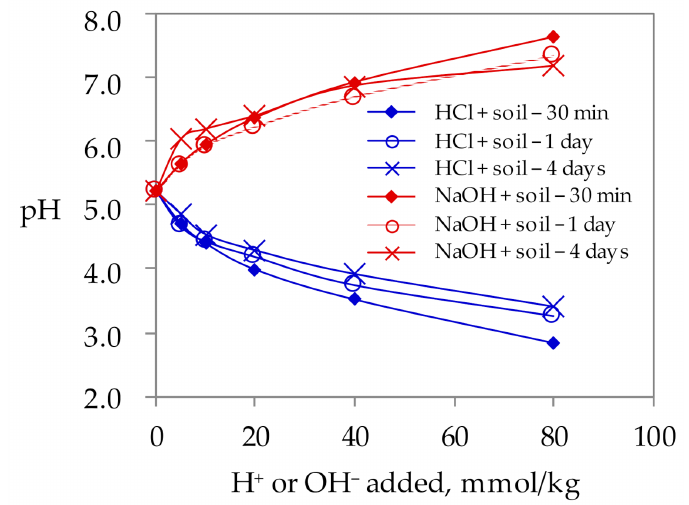
Figure 5. Change in pH of soil suspension after the addition of different amounts of HCl or